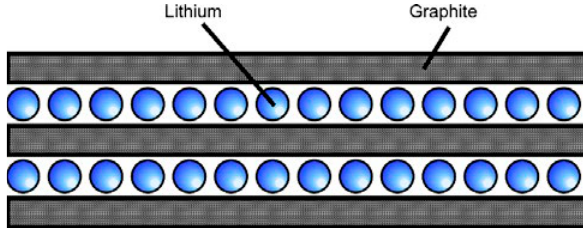
Figure 8. Intercalation of lithium